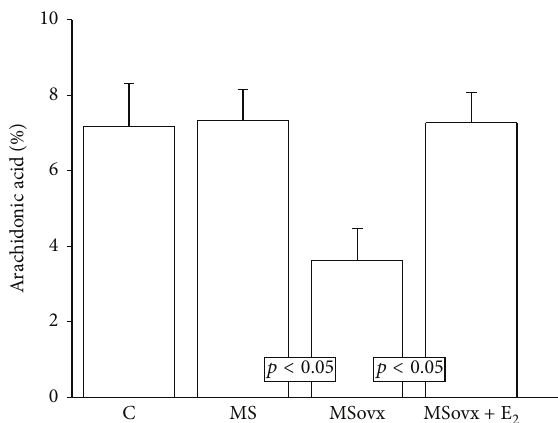
Figure 1: Effect of the estrogen removal and estradiol replacement on the percentage of arachidonic acid in the phospholipids from kidney homogenates. C: control, MS: metabolic syndrome, MSovx: metabolic syndrome ovariectomized, and MSovx + E 2 : metabolic syndrome ovariectomized plus estradiol. Data are means ± SE; 𝑛 = 7 in each group. Comparison between MS and MSovx versus MSovx + E 2